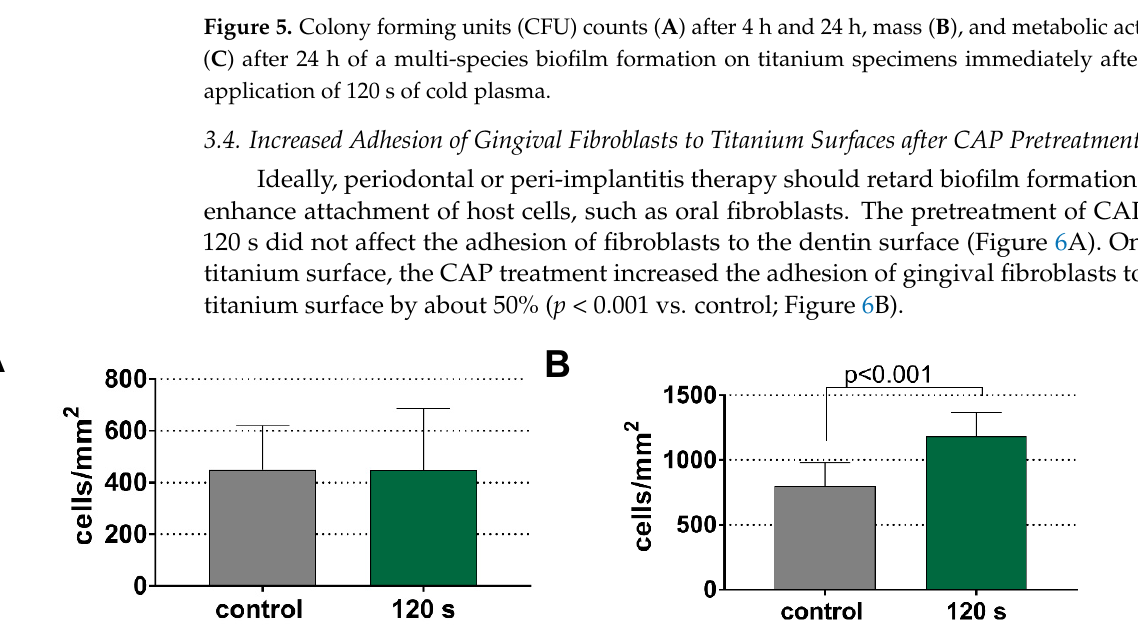
Figure 6. Gingival fibroblast counts per mm 2 on dentin ( A ) and titanium ( B ) specimens after pretreatment of 120 s of cold plasma.